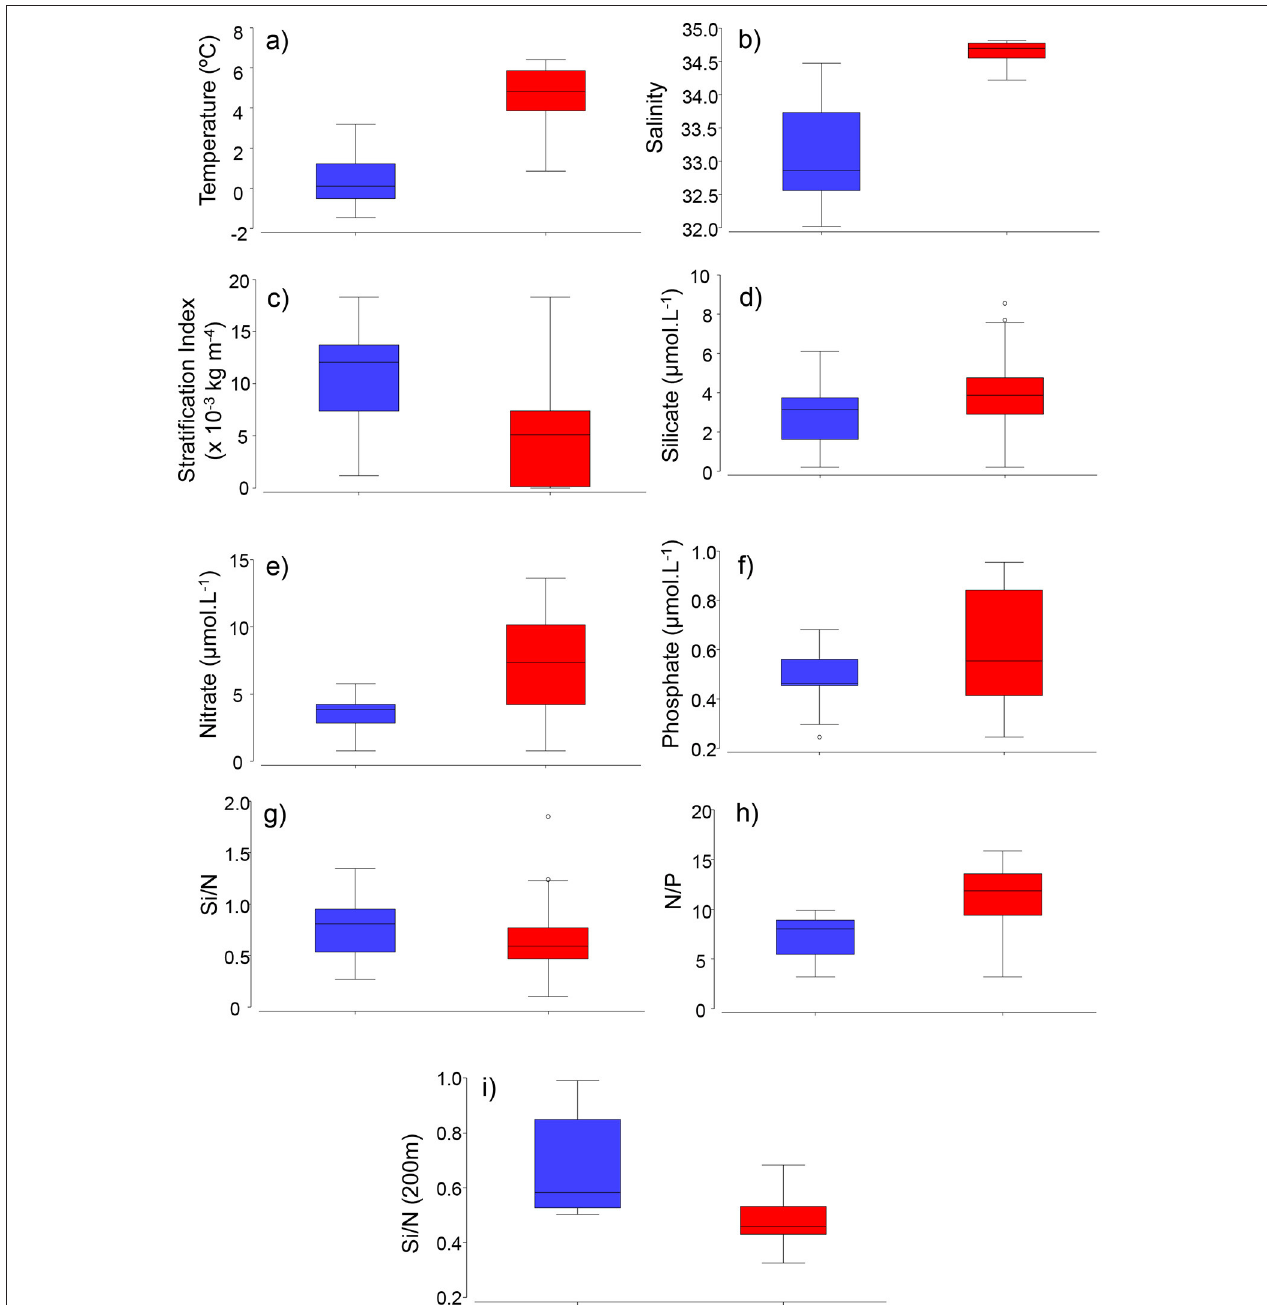
FIGURE 4 | Boxplots of environmental factors. (a) temperature, (b) salinity, (c) stratification index (x 10 − 3 kg m − 4 ), (d) silicate ( µ mol L − 1 ), (e) nitrate ( µ mol L − 1 ), (f) phosphate ( µ mol L − 1 ), (g) Si/N, (h) N/P, (i) Si/N ratios at 200m (winter and/or pre-bloom values) in Arctic (blue) and Atlantic (red) -influenced waters of the Labrador Sea.